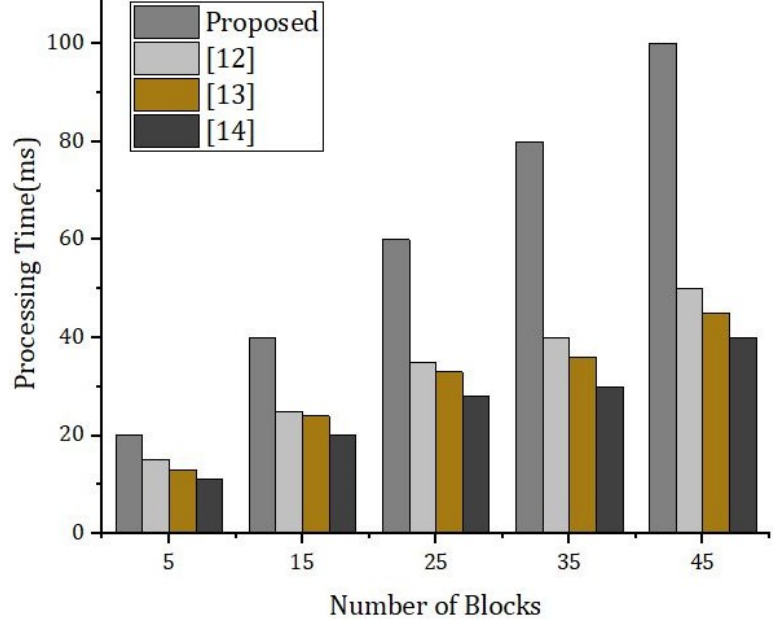
Figure 19. Simulation results based on the execution time and the cache hit rate.